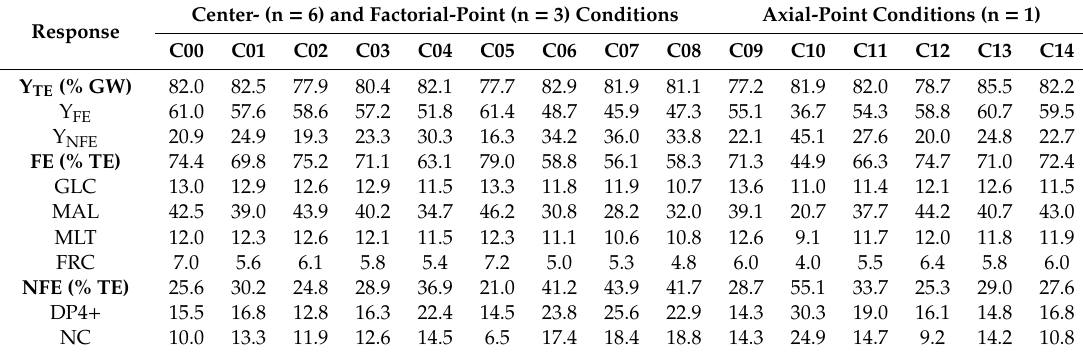
Table 3. Final (90-min) response values for each condition.